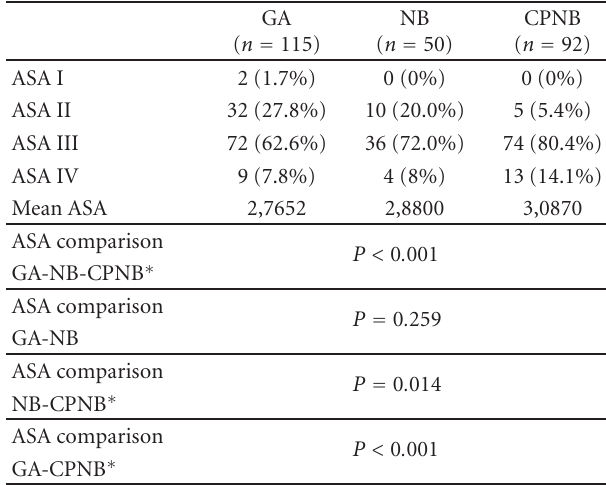
Table 2: ASA status of patients.